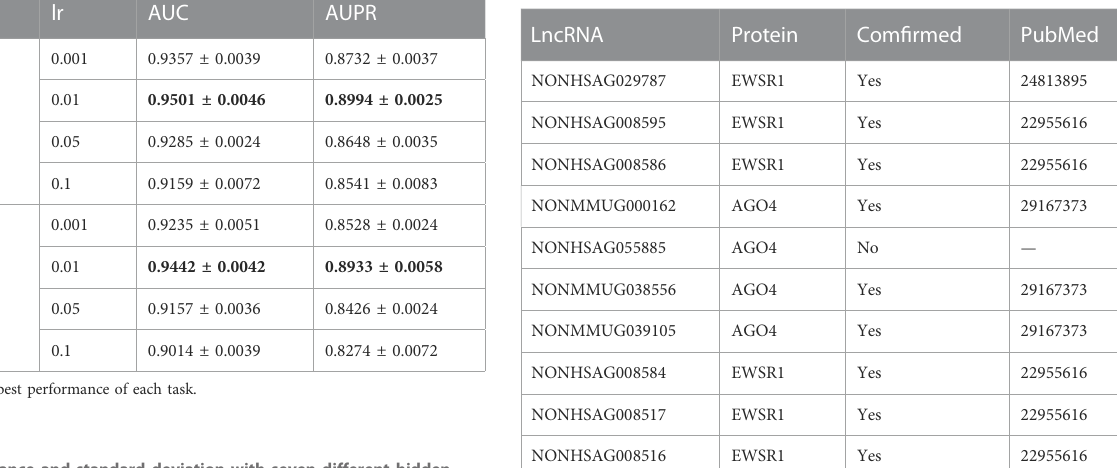
TABLE 8 The predicted top 10 potential lncRNA-protein interaction pairs with